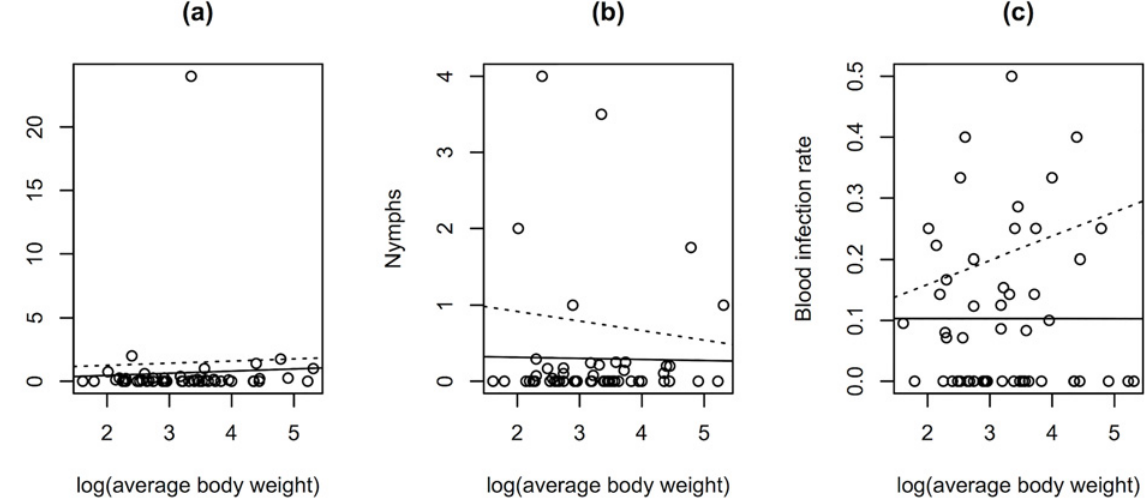
Fig 2. Body weight as a null model for presence or absence of tick infestation and B . burgdorferi s.l. infection in birds. Graphs depict: (a) larvae per bird by log(average body weight), (b) nymphs per bird by log(average body weight), and (c) bird infection by log(average body weight). Each data point represents one bird species. One outlier point in plot (a) represents Lark Sparrows ( Chondestes grammacus ). The solid line is a regression on all species, while the dotted-line is a regression on zero-truncated data (species with positive results only).